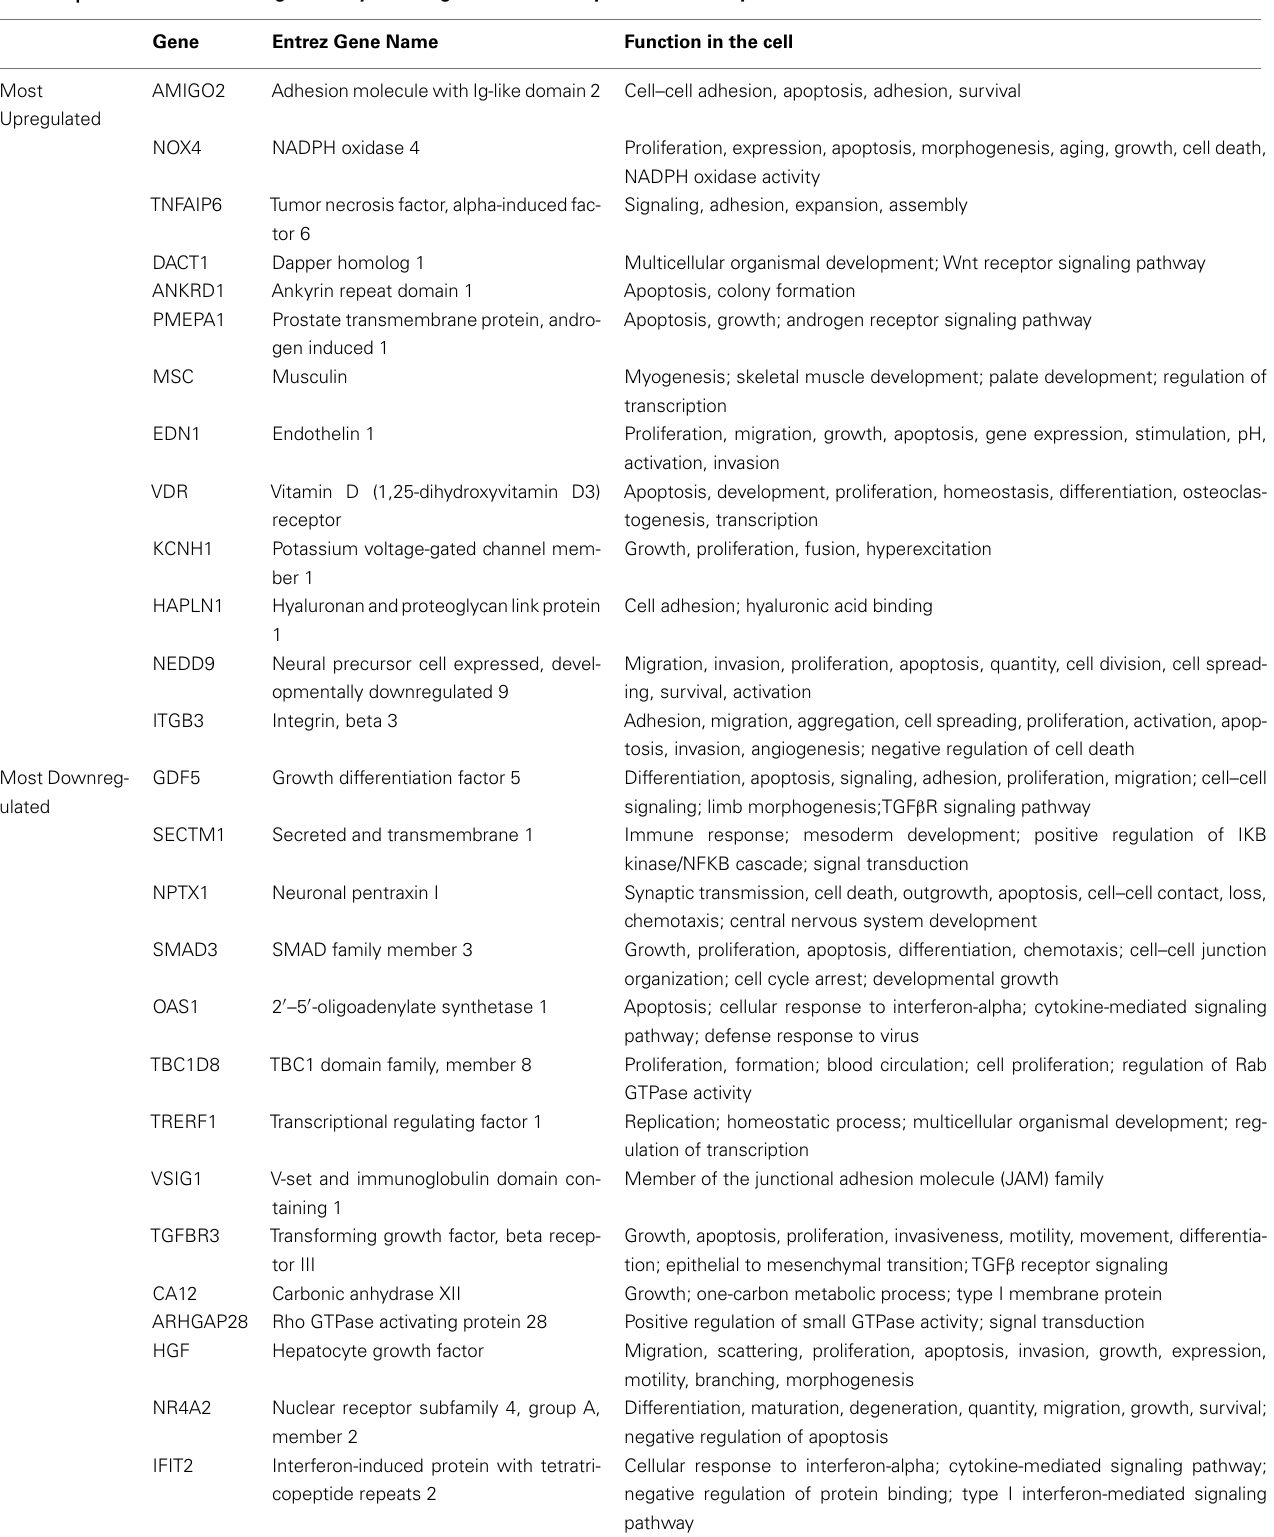
TableA3 | Details of the most significantly altered genes within the palatal mesenchyme. Gene Entrez Gene Name Function in the